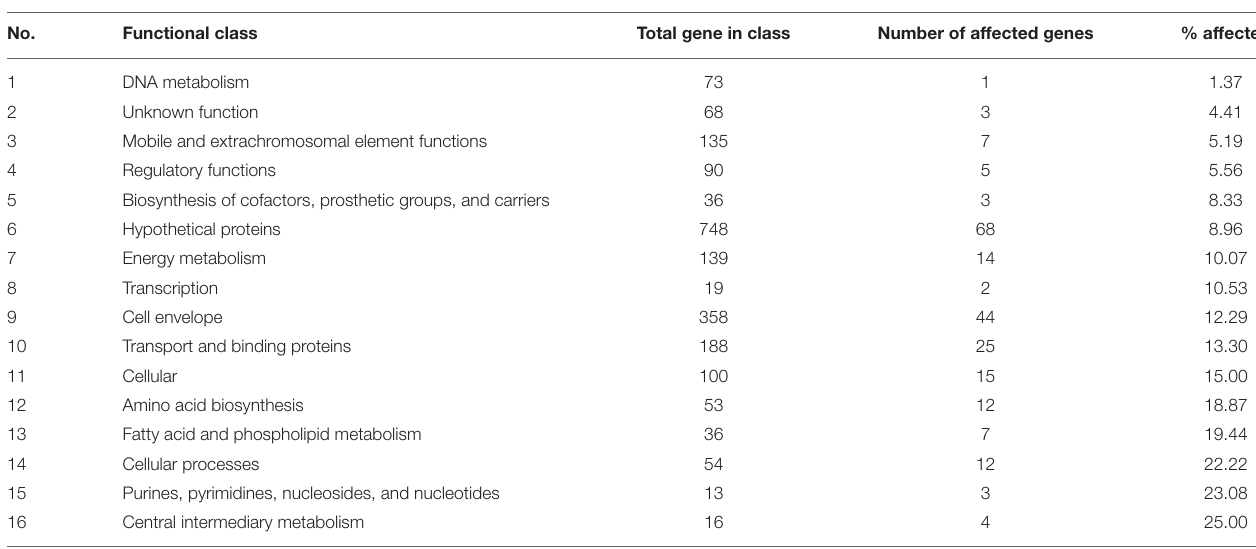
TABLE 1 | Number for σ B -regulated genes in each functional